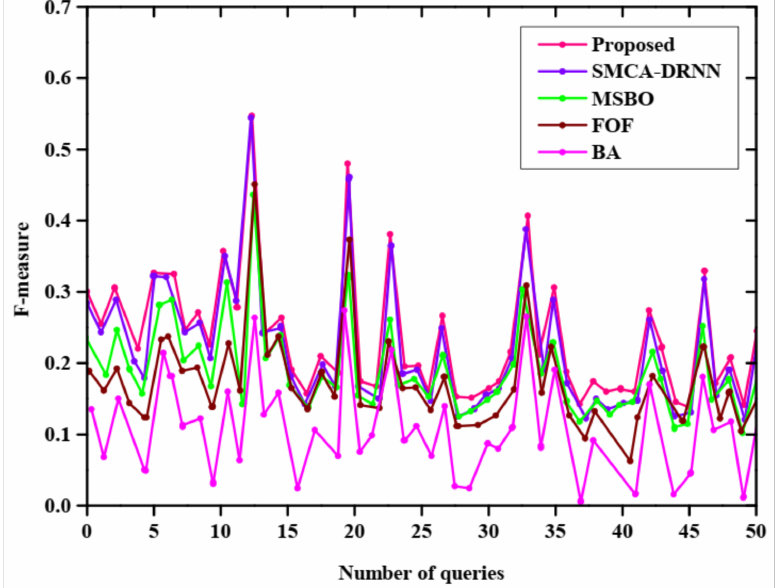
Figure 7. F-measure without query expansion.